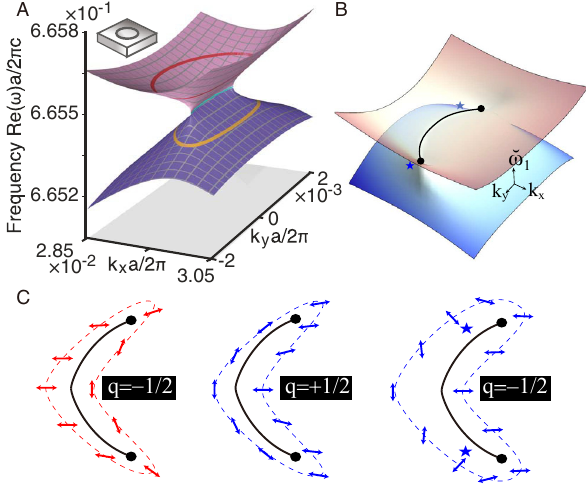
Figure 5: (A) An example of a Dirac degeneracy turning into a bulk Fermi arc due to non-Hermiticity. The system is a rhombic-lattice photonic crystalslab. (B) The existenceof circularly polarized states near the two ends of the bulk Fermi arc (the two exceptional points) on the lower band. (C) Polarization state distributions on different iso-frequency contours around the bulk Fermi arc. For the upper band, the winding number of polarization states equals to − 1/2 whichisexpected.Meanwhile,forthelowerband,ifthetwoC-points are not enclosed by the chosen iso-frequency contour, the winding number can unexpectedly be + 1/2. (A) is adapted from [99], while (B) and (C) are adapted from